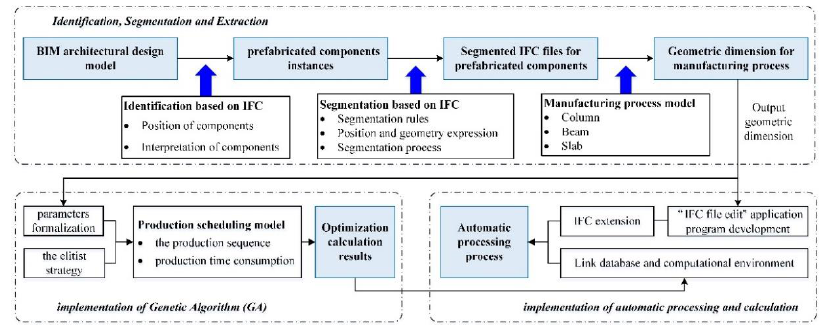
Figure 1. Overview of the proposed automated optimization system.